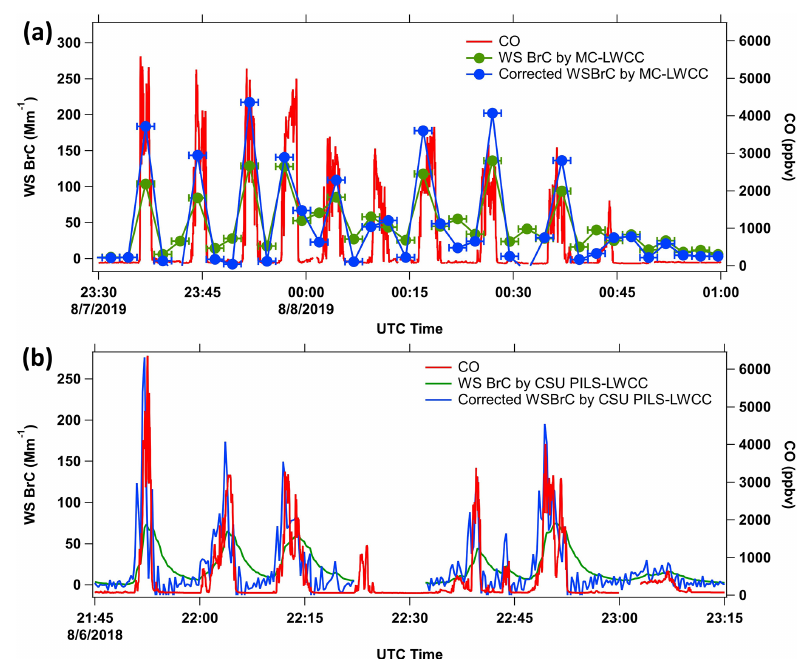
Figure 6. Time series of water-soluble BrC (WS BrC) corrected for baseline drift and hysteresis (blue) compared to original data (green) and CO concentrations (red) for (a) the MC-LWCC measurement and (b) the CSU PILS-LWCC measurement for the same flights shown in Fig. 4a and b, respectively. Horizontal error bars in (a) represent the MC-LWCC interval.